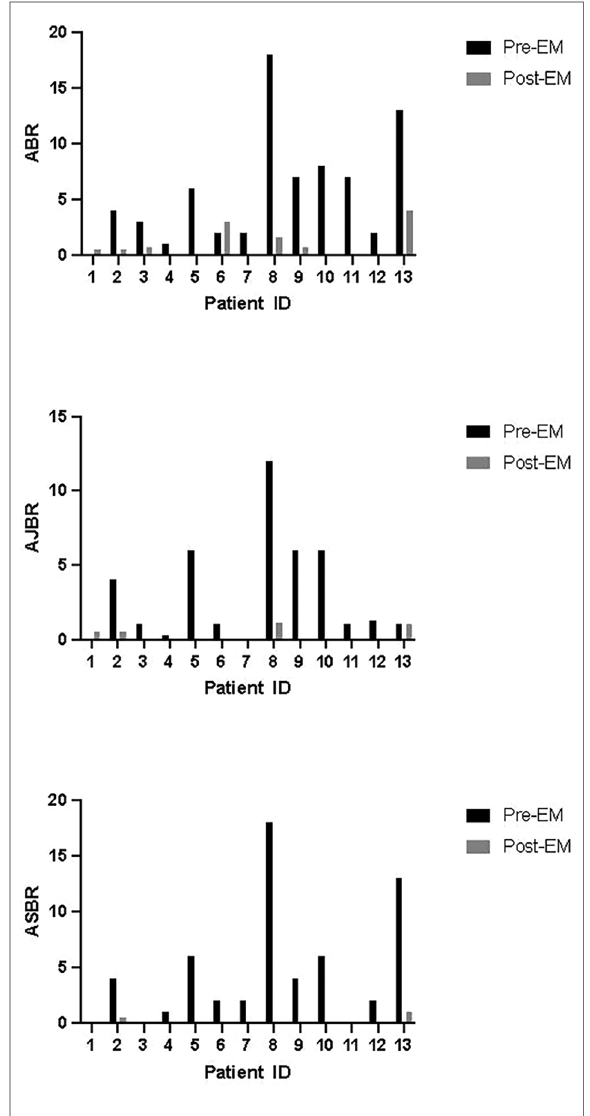
FIGURE 1 Bleeding rates of each patient before and after switching to emicizumab. ABR, annualized bleeding rate; AJBR, annualized joint bleeding rate; ASBR, annualized spontaneous bleeding rate; EM,